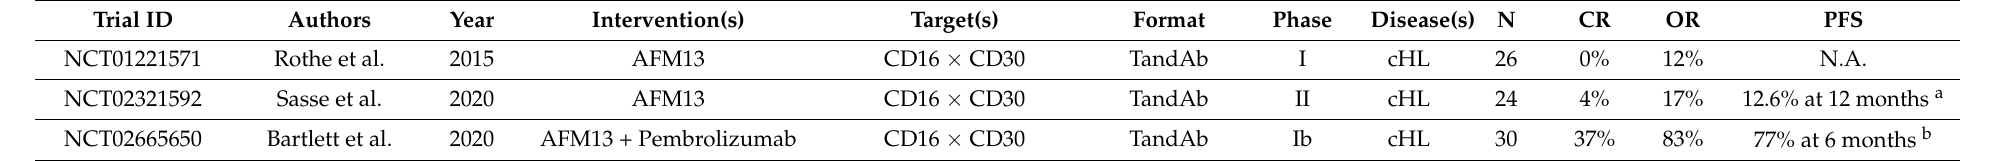
Table 9. Clinical trials of bispecific NK-cell-engaging constructs in